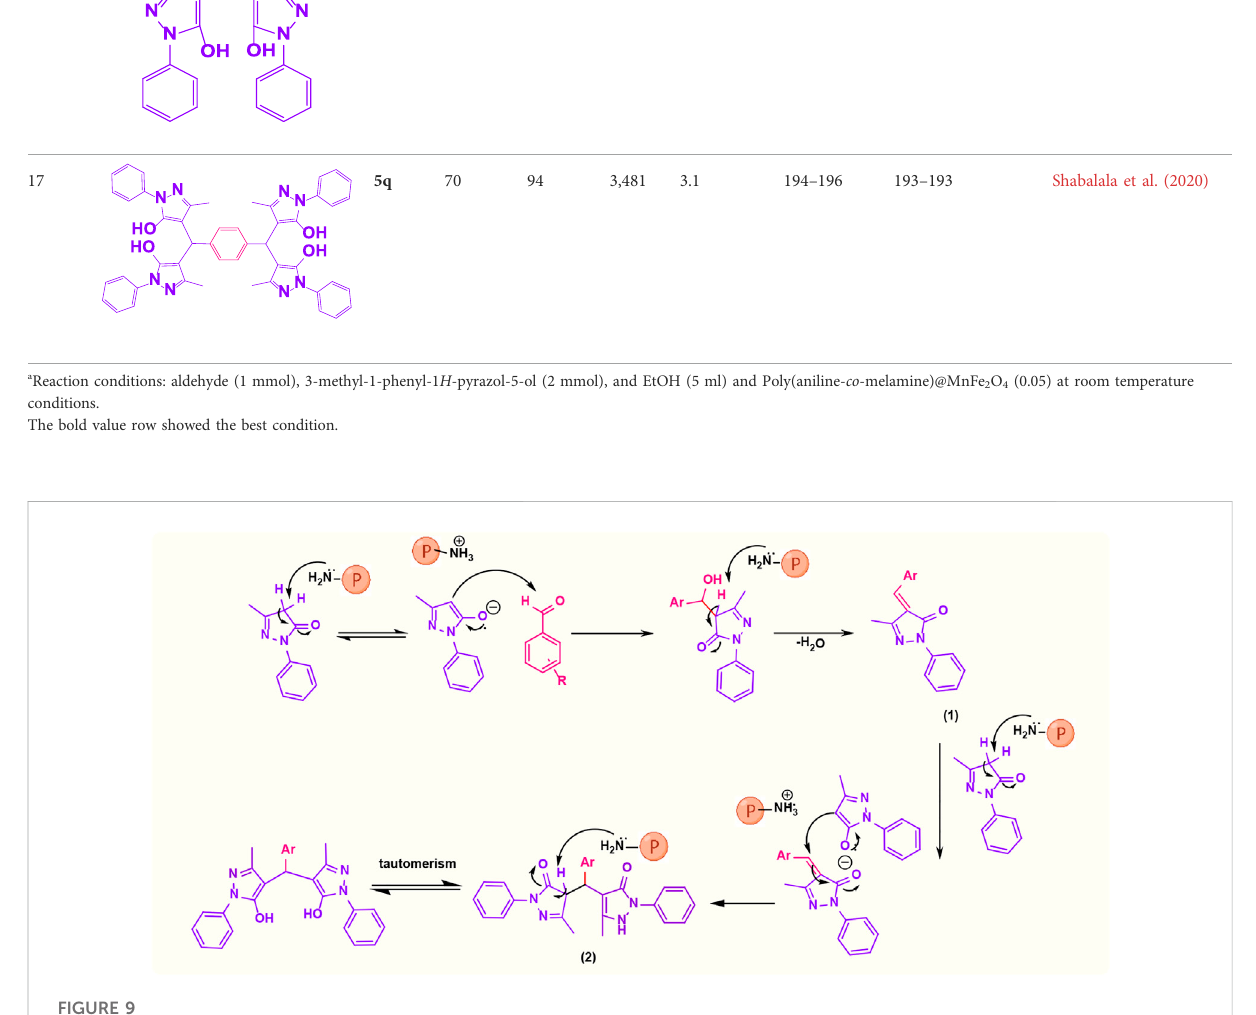
Suggested mechanistic scheme for the synthesis of 4,4 ′ -(arylmethylene)bis(1 H -pyrazole-5-ol) derivatives catalyzed by poly(aniline- co - melamine)@Mn(Fe 2 O 4 ). ℗ represents polymer-based